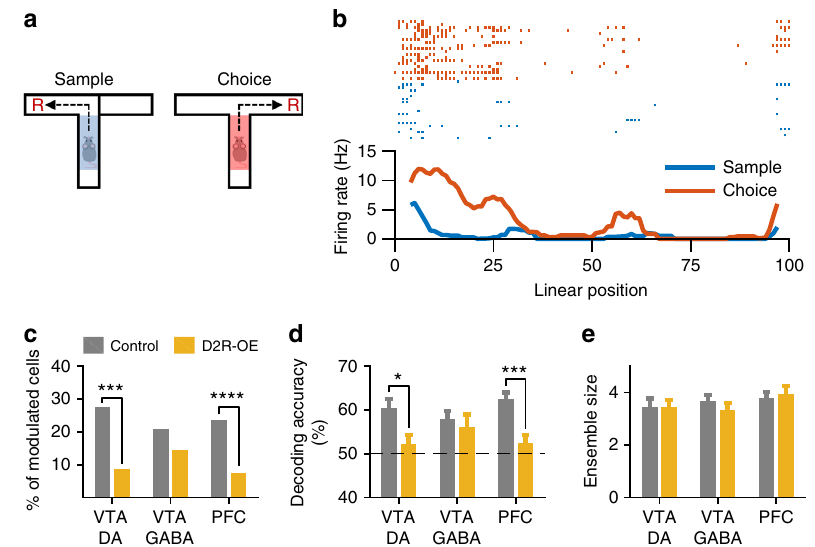
Fig. 6 Selective disruption of task phase encoding in VTA DA and PFC neurons of D2R-OE mice. a Firing rates of VTA and PFC neurons were compared in the center arm of the maze between sample and choice phases. b Example neuron that was more active in the choice phase than in the sample phase (linear position 50 corresponds approximately to the decision point of the T-maze). c Proportion of VTA DA (Control: n = 113; D2R-OE: n = 102), VTA GABA (Control: n = 124; D2R-OE: n = 104) and PFC (Control: n = 187; D2R-OE: n = 185) neurons whose fi ring rate differed signi fi cantly in the center arm during sample and choice phases ( p < .05, rank-sum test). The percentage of phase-selective VTA DA and PFC neurons was lower in D2R-OE mice (*** p < .001, **** p < .0001, Fisher ’ s exact test), but not the percentage of VTA GABA neurons ( p = 0.23). d Accuracy (% correct) with which task phase (sample or choice) could be decoded from the activity of VTA and PFC neurons using a linear classi fi er (see Methods). Dashed line indicates chance level. Error bars represent mean ± s.e.m decoding accuracy over sessions (Control/D2R-OE: n = 29/26, 32/30 and 47/45 sessions for VTA DA, VTA GABA and PFC neurons, respectively). Decoding based on the activity of VTA DA and PFC neurons was signi fi cantly impaired in D2R-OE mice (* p < .05; *** p < .001, rank-sum test), but decoding based on VTA GABA neurons was not affected ( p = 0.99). e Mean ± s.e.m number of neurons in each session that were used for decoding analysis in d . These numbers did not differ between groups ( p > 0.05, rank-sum test)